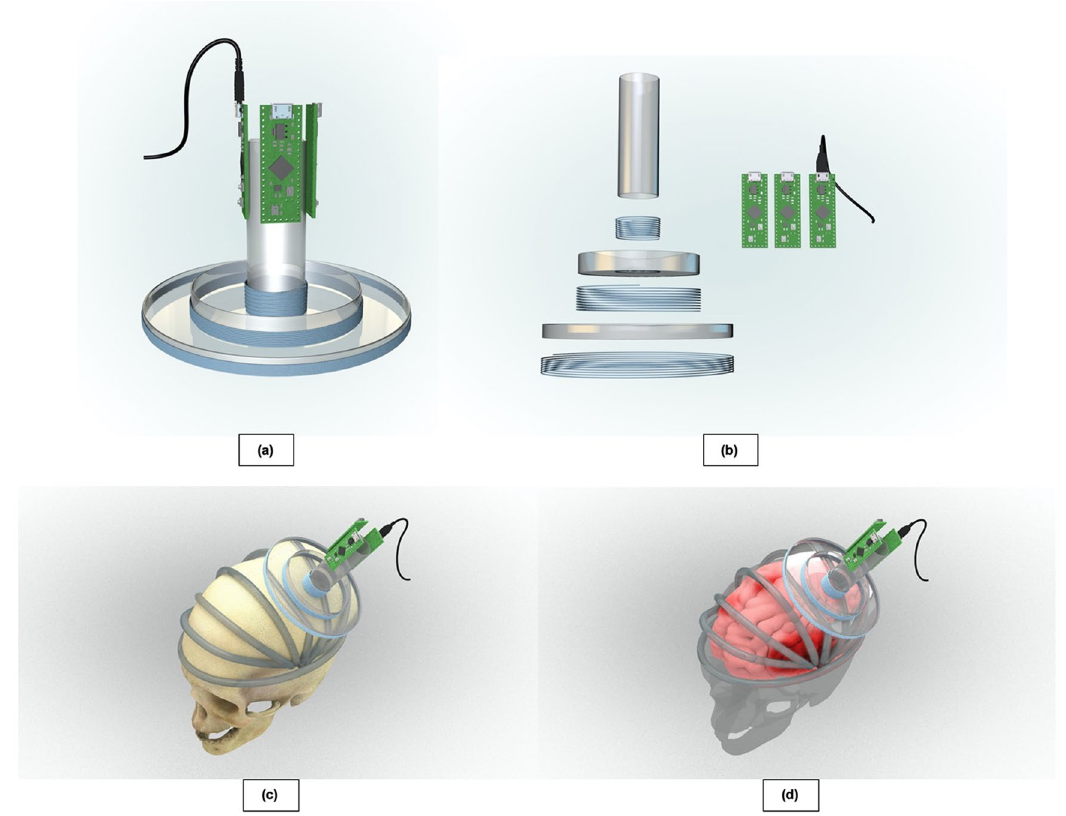
Figure 1. ( a) 3D models of the three coil ECD sensor is shown. The variability in coil sizes allows for scanning at different depths, and the concentric design aligns the magnetic field distributions of each sensor to increase scanning specificity. In image ( b ), we take the ECD sensors apart to demonstrate their components, which include three wire solenoids, three plastic frames, and three inductance-to-digital converting devices. ( c ) The sensor is moved across the eight scanning paths while recording R p values. ( d ) Areas of bleeding result in decreased R p measurements, while areas of normal brain tissue leave R p